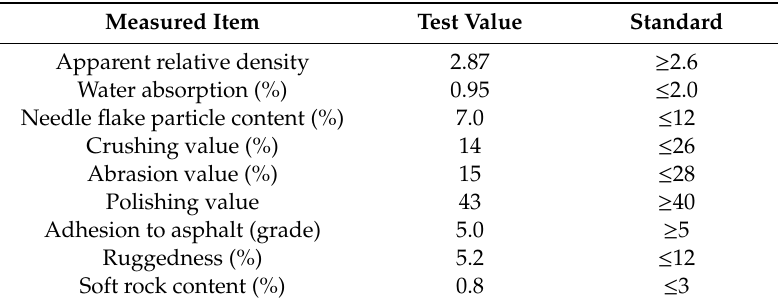
Table 2. Technical properties of coarse aggregate.